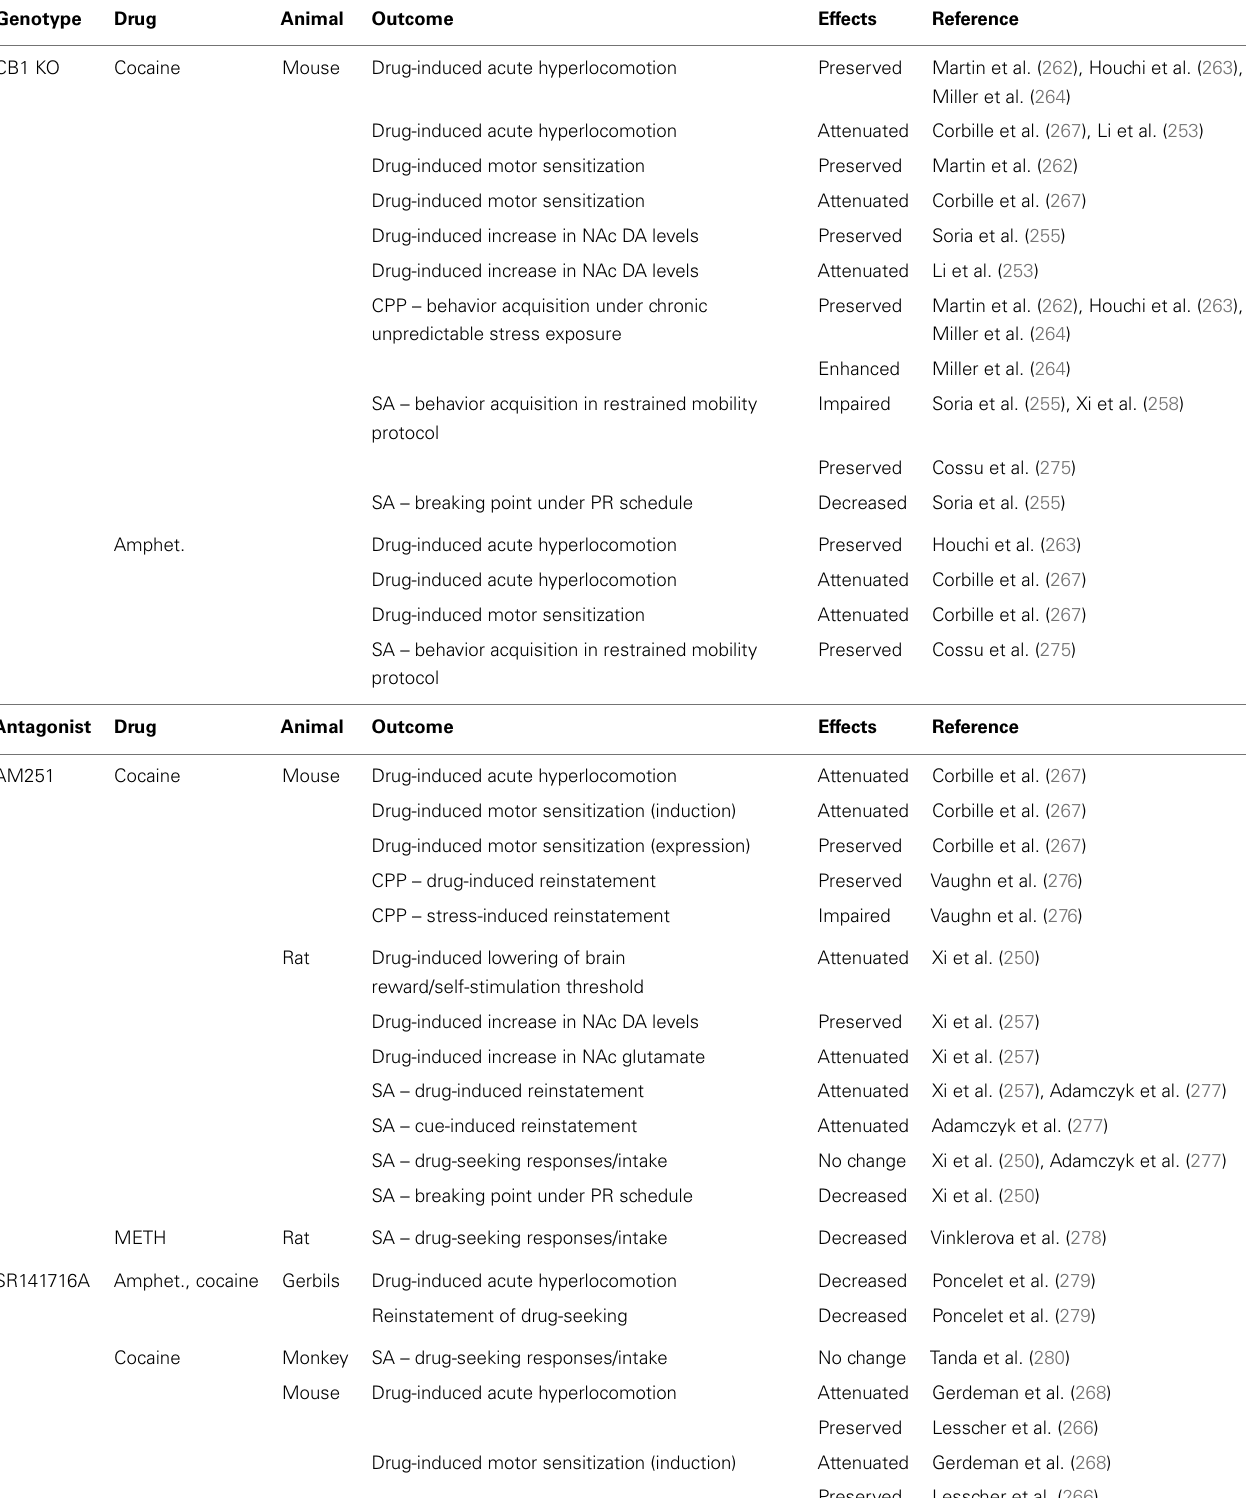
Table 3 | Effects of CB1 cannabinoid receptor deletion and properties of psychostimulants; CB1 receptor antagonists and properties of